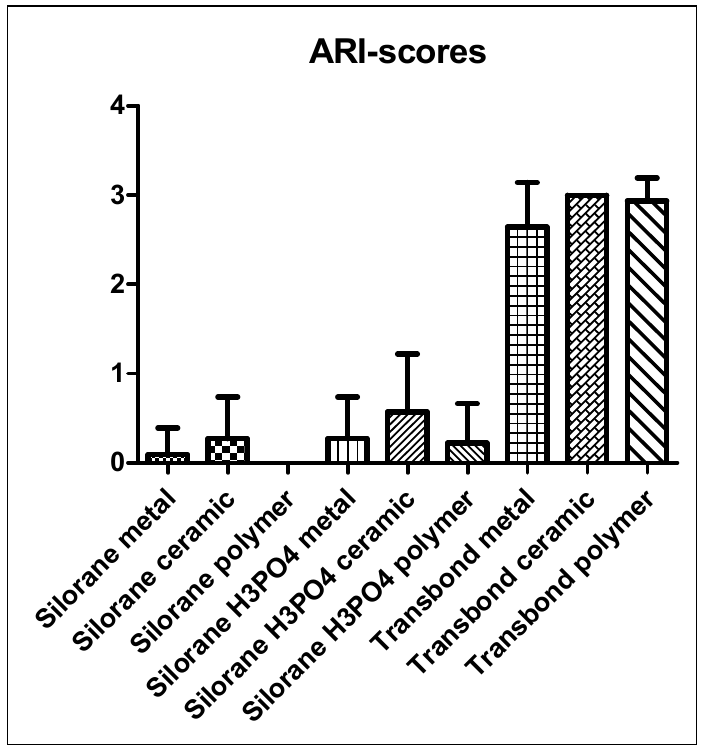
Figure 2. ARI scores of all test groups. High ARI scores indicate a fracture at the adhesive–enamel interface. Low scores indicate fractures between adhesive and bracket.